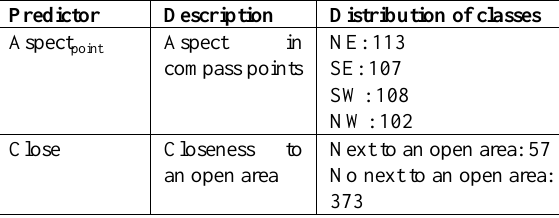
Table 4. Descriptions of extracted categorical predictor variables within sample plots